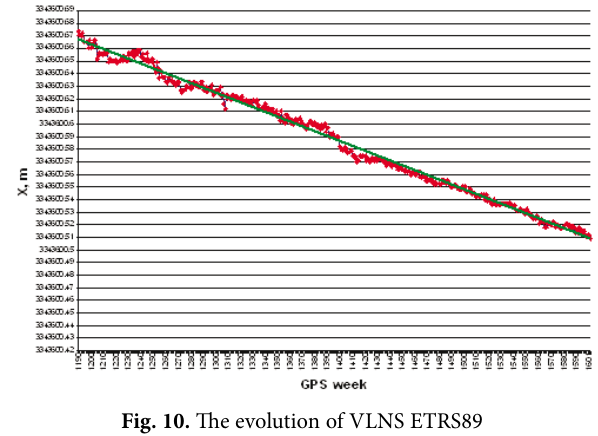
Fig. 10. The evolution of VLNS ETRS89 geocentric coordinates